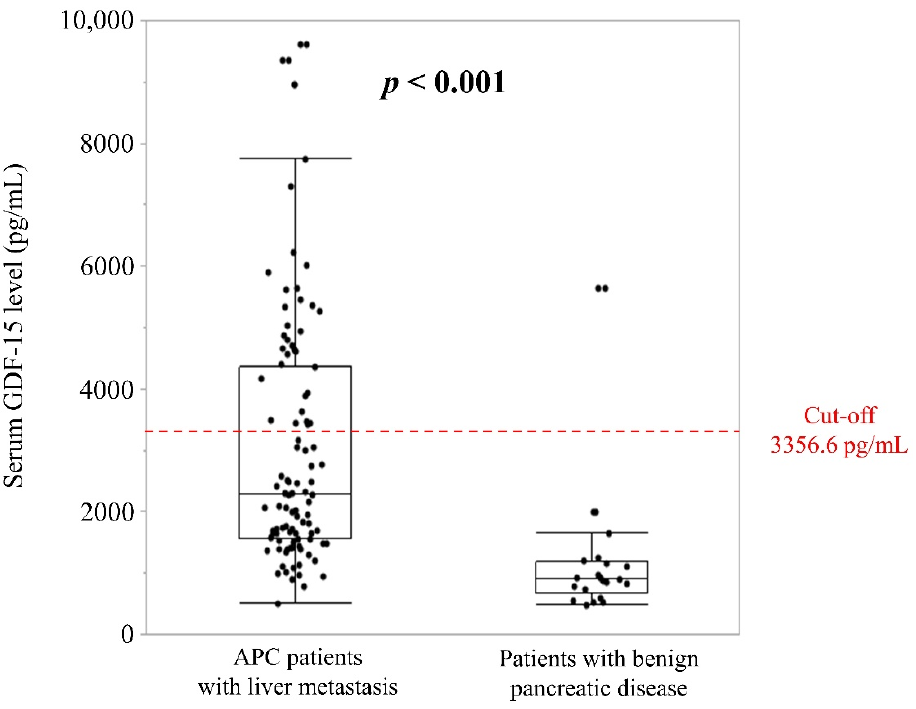
Figure 2. Serum GDF-15 levels in APC patients with liver metastasis and benign pancreatic diseases. The red dotted line represents the cut-off for serum GDF-15 levels, determined as the mean plus twice the standard deviation of GDF-15 in patients with benign pancreatic disease, equal to 3356.6 pg/mL.